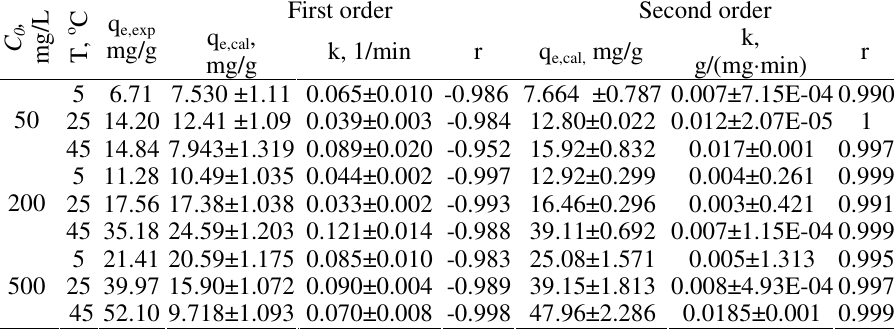
Table 6. Comparison of the adsorption kinetic models of PEG (10000) on EG First order Second